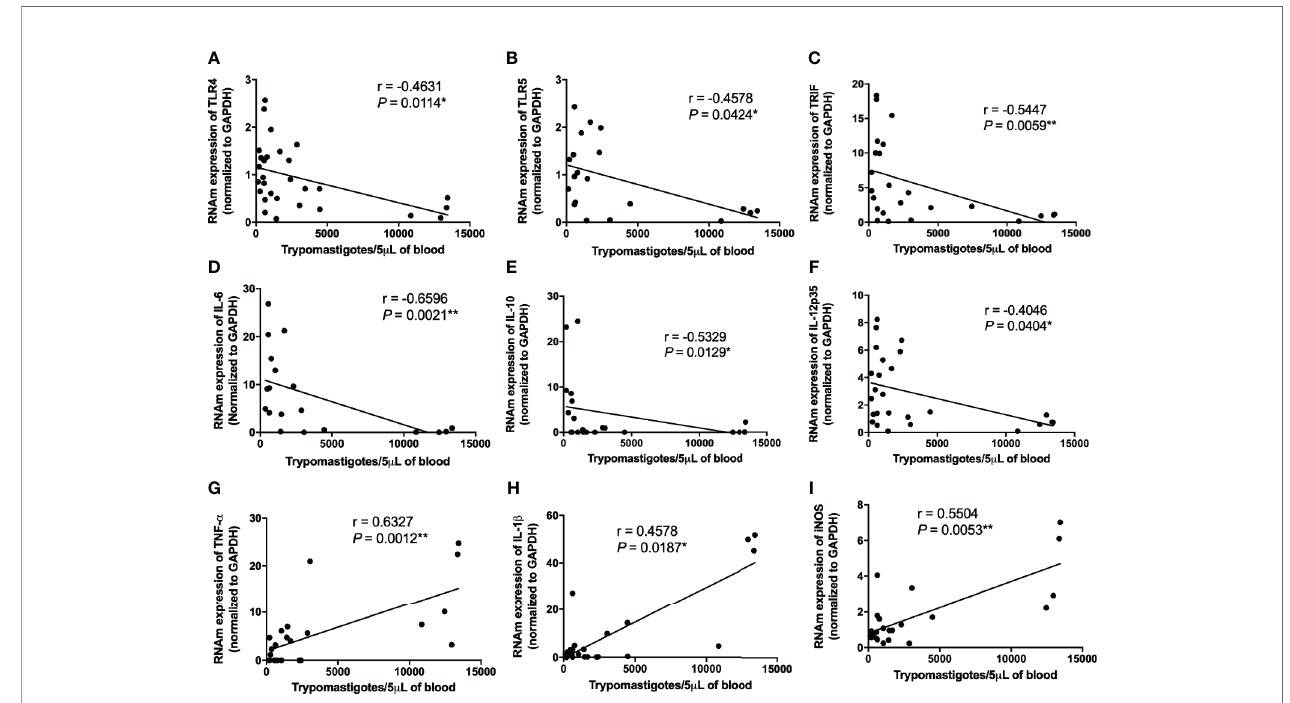
FIGURE 7 | Low TLR4, TLR5, TRIF, IL-6, IL-10, IL-12p35 and high TNF- a , IL-1 b , iNOS mRNA expression in cardiac tissue are correlated with high Trypanosoma cruzi virulence. The mRNA expression levels of TLR4 (A) , TLR5 (B) , TRIF (C) , IL-6 (D) , IL-10 (E) , IL-12p35 (F) , TNF- a (G) , IL-1 b (H) and iNOS (I) were determined by real-time PCR in cardiac tissue from Swiss mice infected by the intraperitoneal route with 1 × 10 4 blood trypomastigote forms of T. cruzi strains that showed low (AM64 + 3253) (n = 10), medium (PL1.10.14 + CL) (n = 10), and high (Colombian + Y) (n = 10) virulence. The expression levels were normalized to the expression level of GAPDH. The results are expressed as the means ± standard errors and Spearman test was used. * p < 0.05; *** p <